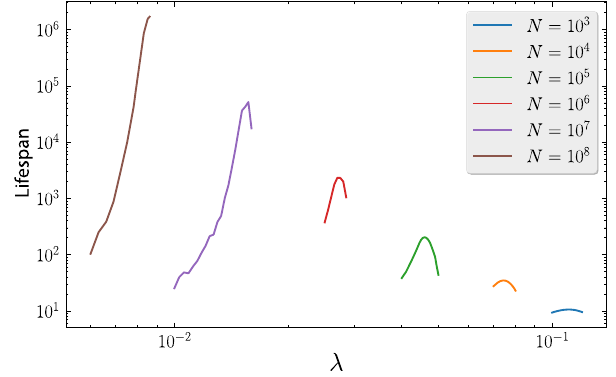
of SIS epidemics c